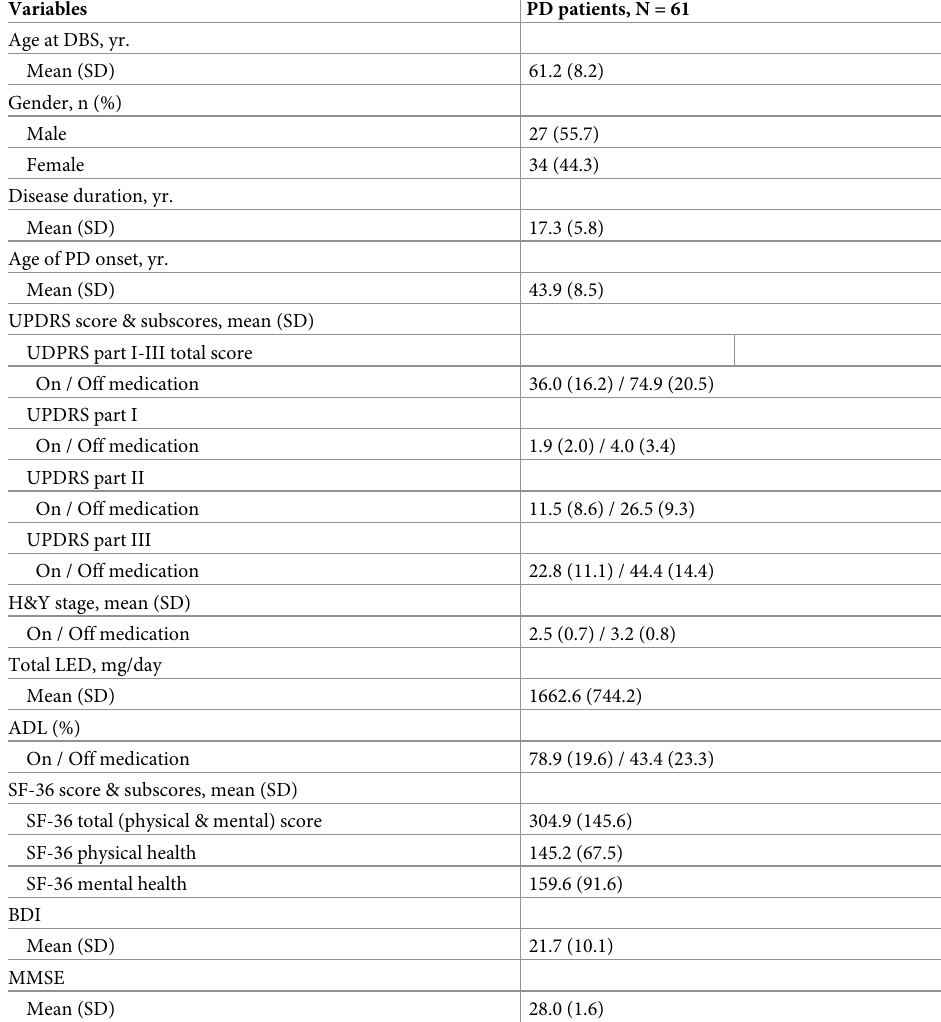
Table 1. Demographics and PD-associated characteristics in PD patients with STN DBS. Variables PD patients, N =